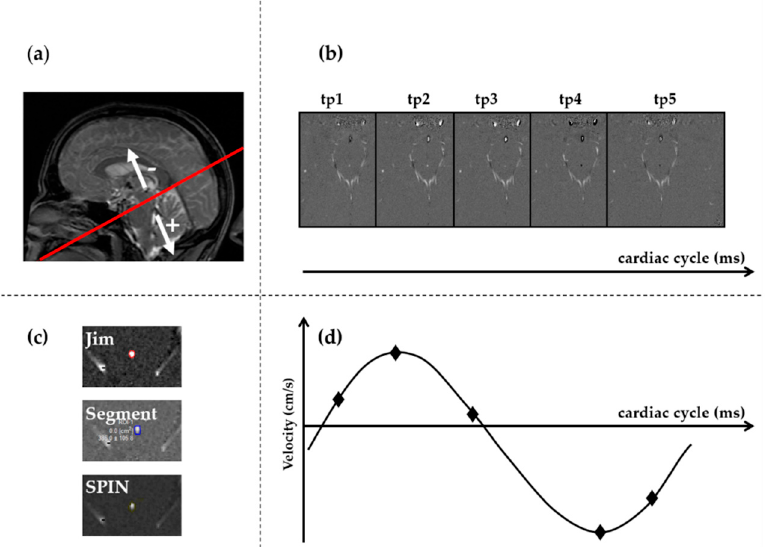
Figure 1. Phase-contrast (PC) MRI of the aqueduct of Sylvius (AoS): acquisition and processing. The acquisition plane was positioned on the sagittal localizer, as displayed by the red line in ( a ). The phase image sign convention is schematized in ( a ): the positive flow is that through the plane in the caudal direction, i.e., to the fourth ventricle, during the systolic phase. In ( b ), examples of phase images at 5 of the 32 time points (tp) are shown: caudal flows are visible as bright pixels in the phases of time points tp1, tp2, and tp3. Cranial flows are visible as dark pixels in the phase images of the tp4, and tp5. The time point with the highest flow-parenchyma contrast is show in ( c ), where the AoS segmentations using the three software are shown. A schematic of typical cerebrospinal fluid (CSF) velocity of any pixel inside the AoS across the normalized cardiac cycle is represented in ( d ), where the velocities of the five time points are